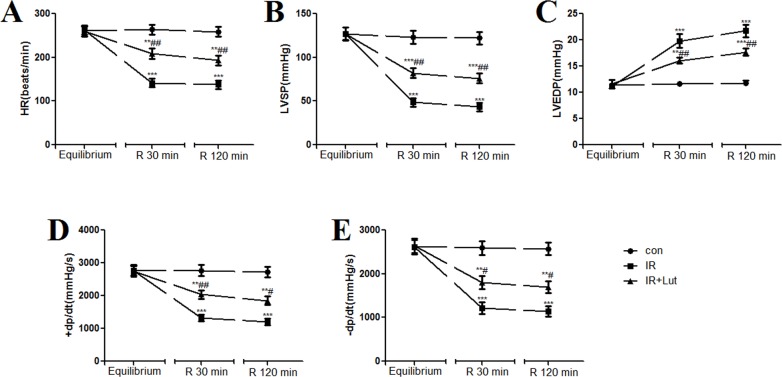
Effects of luteolin on various parameters of hemodynamic measurements during a perfusion period in isolated rat hearts.I/R decreased HR (A), LVSP (B), +dp/dt (D) and -dp/dt (E), and increased LVEDP (C), ***p<0.001 as compared to the control group. While LUT pre-treatment increased HR (A), LVSP (B), +dp/dt (D) and -dp/dt (E), and decreased LVEDP (C), ##p<0.01, #p<0.05 as compared to the I/R group. Equilibrium indicated baseline, R 30min indicated reperfusion 30 min, and R 120 min indicated reperfusion 120 min.